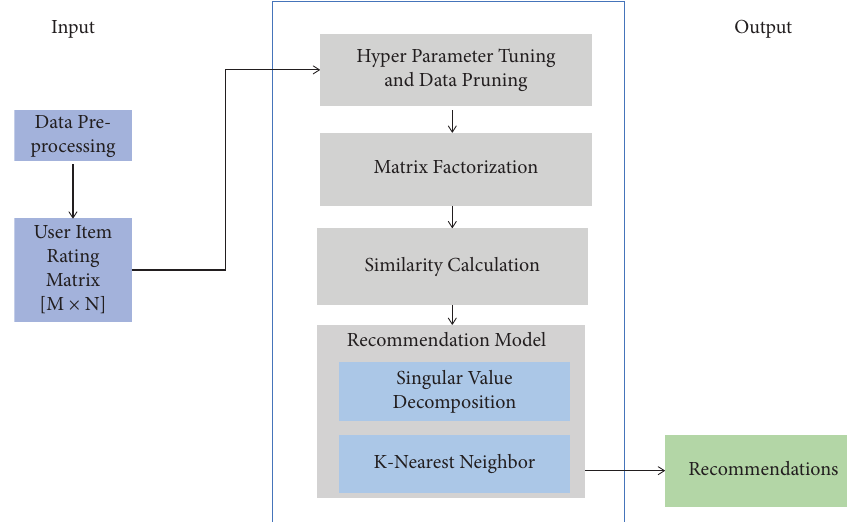
Figure 1: Architecture of the proposed collaborative recommender